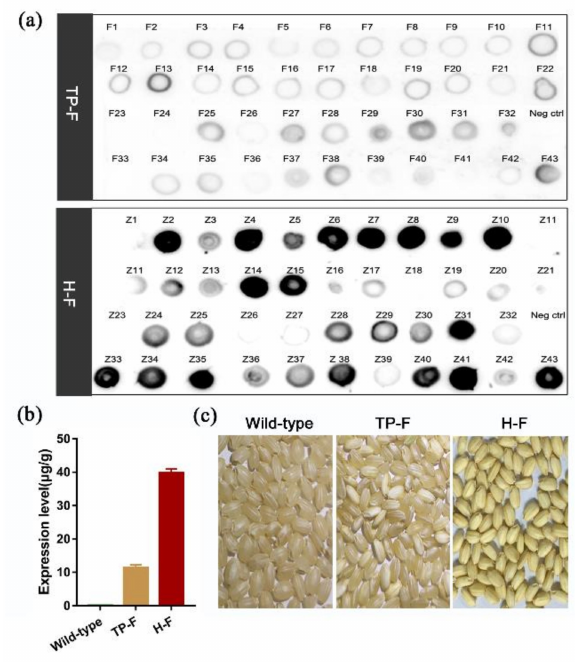
Figure 2. Comparison of hybrid rice expressing the F protein (H-F) and transgenic TP309 rice expressing the F protein (TP-F). ( a ) F protein was detected in TP309 transgenic lines (TP-F) and low-glutelin transgenic lines (H-F) by dot blot using the anti-F Abs. Each dot represents a di ff erent transgenic line. Neg ctrl indicates the negative control of non-transgenic rice TP309. ( b ) The expression levels of H-F and TP-F in rice seeds as quantified using ELISA. ( c ) Phenotype of F-expressing seeds in hybrid transgenic rice (H-F; right), transgenic rice of TP309 (TP-F; middle) and non-transgenic seeds